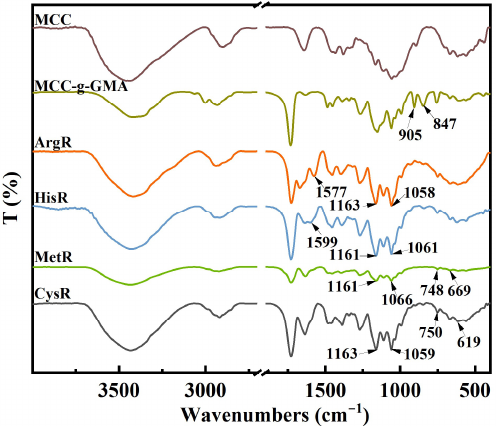
Figure 1. FTIR image of MCC, MCC-g-GMA, and the amino acid resins.